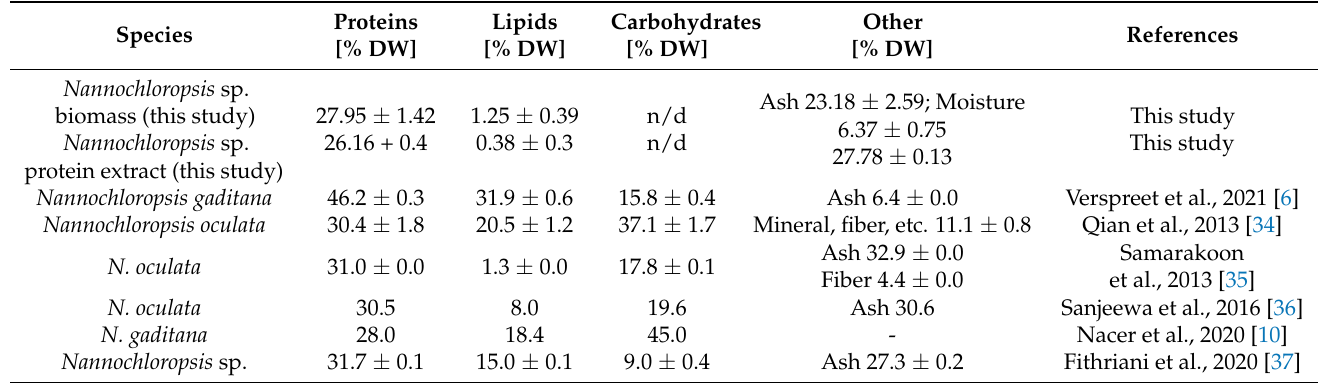
Figure 2. Nannochloropsis sp. protein treated fraction and permeate generation process and resultant protein extracts ( E1 & E2 ), proteins treated enzyme fractions generated using xylanase ( H1 & H2 ) and permeate ( P1 ) and retentate ( R1 ) fractions generated. Table 1. Proximate compositional analysis of the whole Nannochloropsis sp. biomass used for protein and peptide generation in this study and extracted protein from the same biomass, compared to compositional analysis carried out for Nannochloropsis sp.